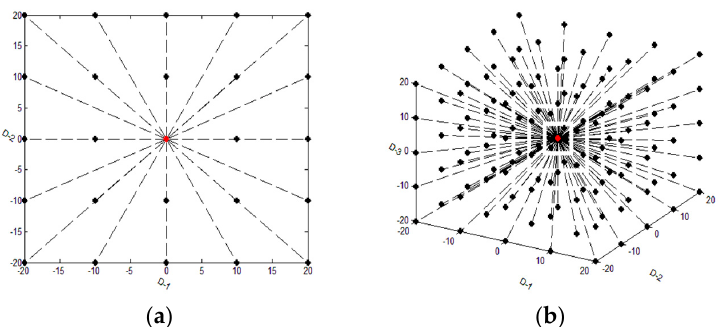
Figure 1. ( a ) The searching situation of wolves in adaptive shrinking grid search (ASGS-CWOA) when the number of dimensions is 2; ( b ) the situation when the number of dimensions is 3, where the step size of migration is as follows: step_a = 10, or the step size of siege, step_c = 10; and the searching number is K = 2 (the red point means the current location of the wolf, while the black ones mean the searching locations of the wolf).